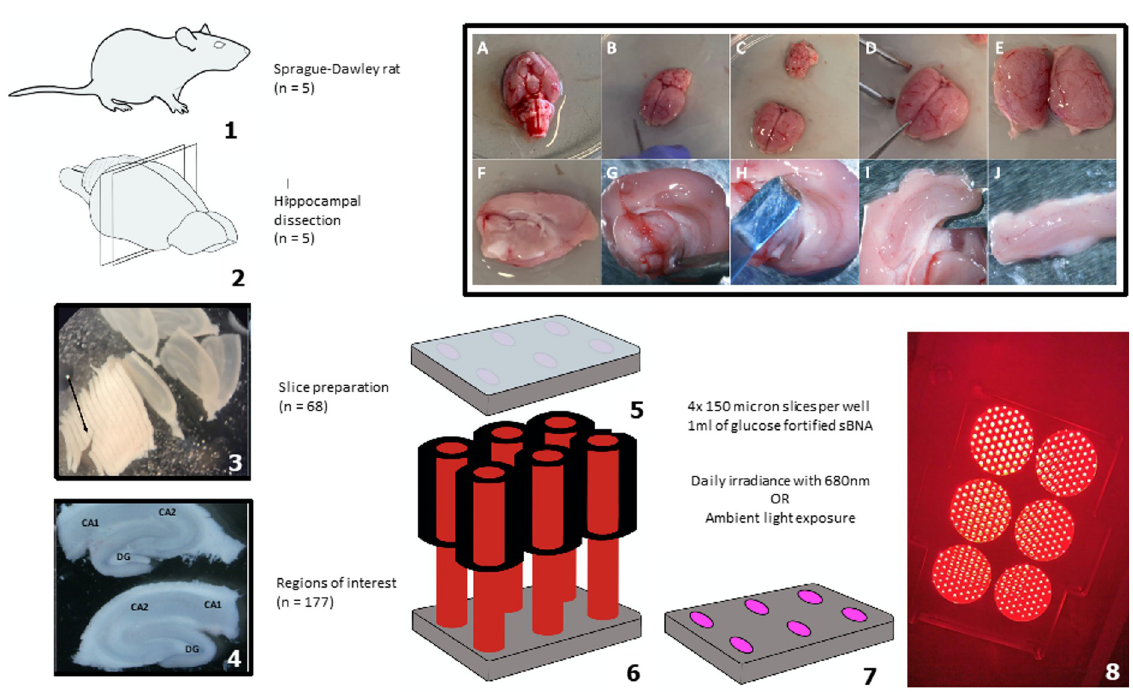
Fig 1. Overview of organotypic hippocampal slice model preparation and administration of PBM. (1) Sprague-Dawley rats were sacrificed; (2) hippocampal dissection (further in top right panel images A-J); (3) manual slice preparation; (4) demonstration of the regions of interest per slice (two slices shown); (5) standard six well culture plate; (6) culture plates exposed to irradiance; (7) culture plates exposed to ambient light; (8) photograph of LED arrangement for irradiance exposure.